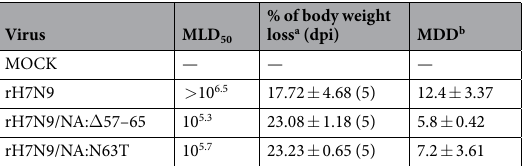
% of body weight loss a (dpi) MDD b